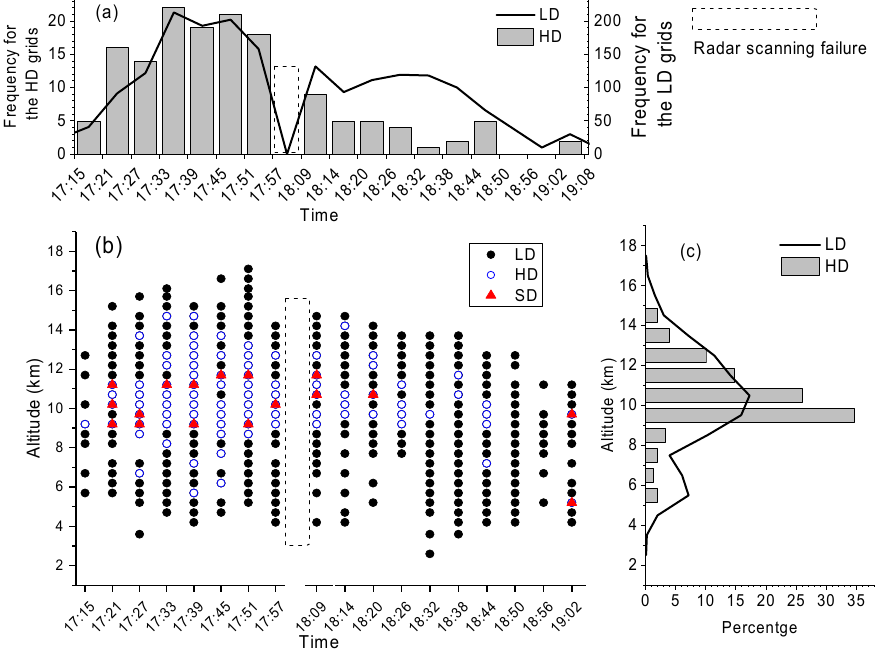
Figure 4. ( a ) Frequency (grids 6 min − 1 ) evolution of the LD and HD grids, ( b ) altitude evolution of the LD, HD and SD grids, and ( c ) altitude distributions of the LD and HD grids in Case 7. (It should be noted that there is a time gap larger than 6 min due to radar failure.).